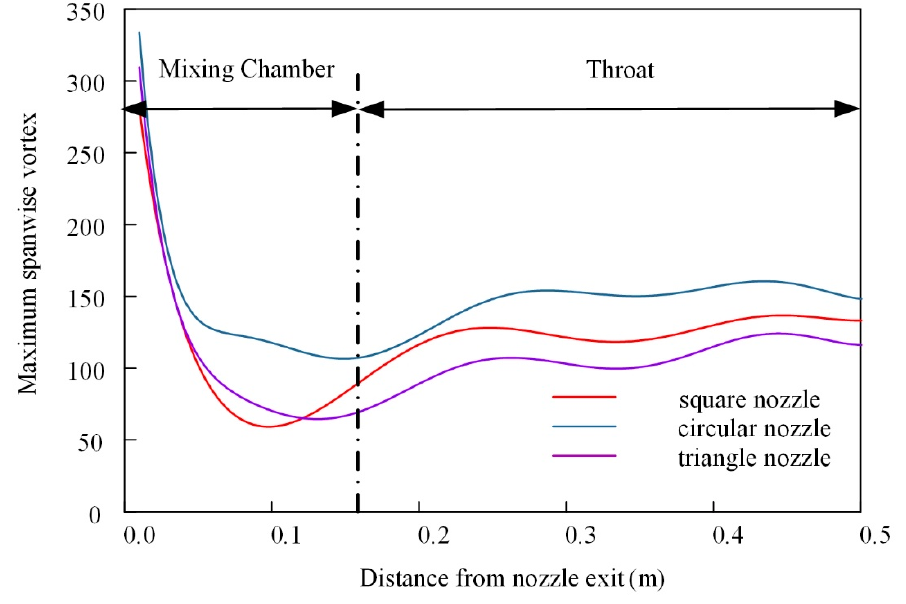
Figure 11. Decay of the maximum spanwise vorticity value.